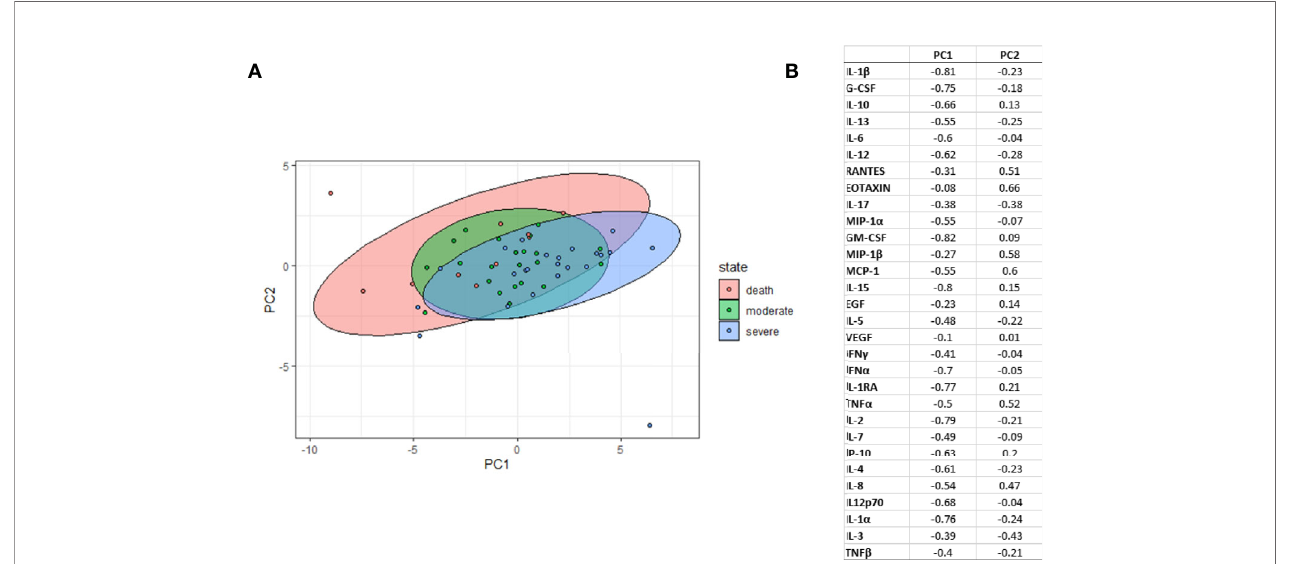
FIGURE 5 | Partial Least-Squares Discriminant Analysis (PLS-DA). (A) Graph of PLS-DA plots representing each sample (dots) with respect to the fi rst 2 PLS-DA components according to severity group (moderate, severe, deceased). (B) Graph of marker loading to the 2 components of the PLS-DA. Principal component (PC).